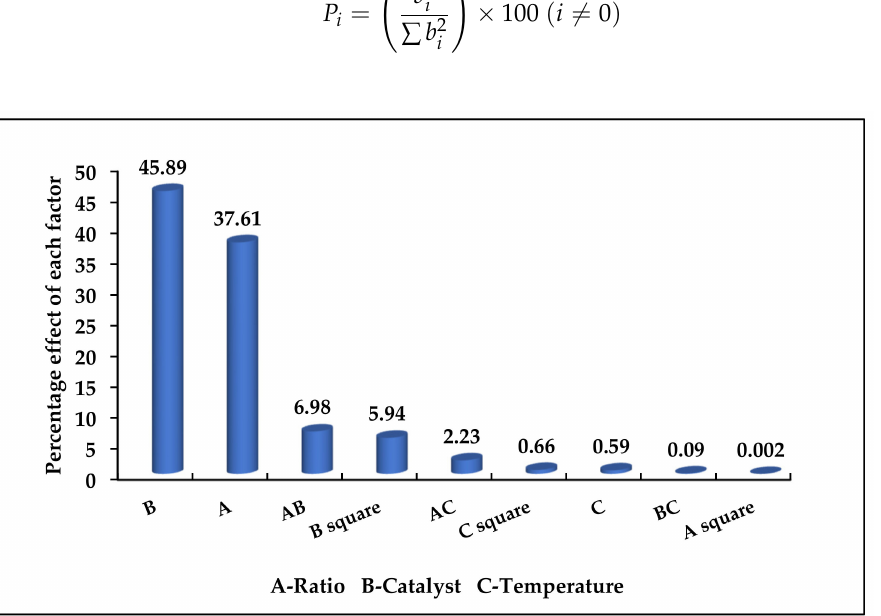
Figure 7. Pareto plot analysis describes the effects of each variables in percentage